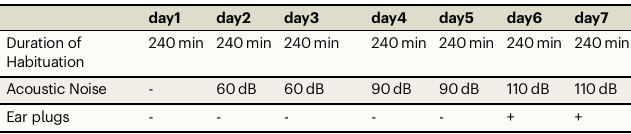
Table 1 | Summary of habituation schedules for awake mouse